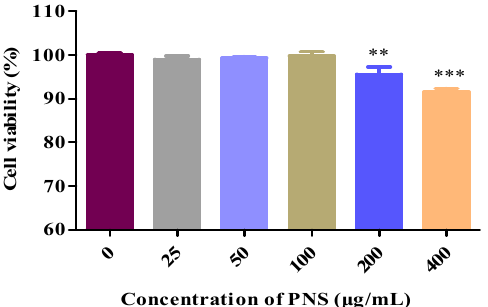
Figure 6. Cytotoxicity tests of PNS on HepaRG cells. Data were presented as mean ± SD ( n = 5). ** and *** denoted result significantly different from that of the control group ( p < 0.01 and p < 0.001, respectively).